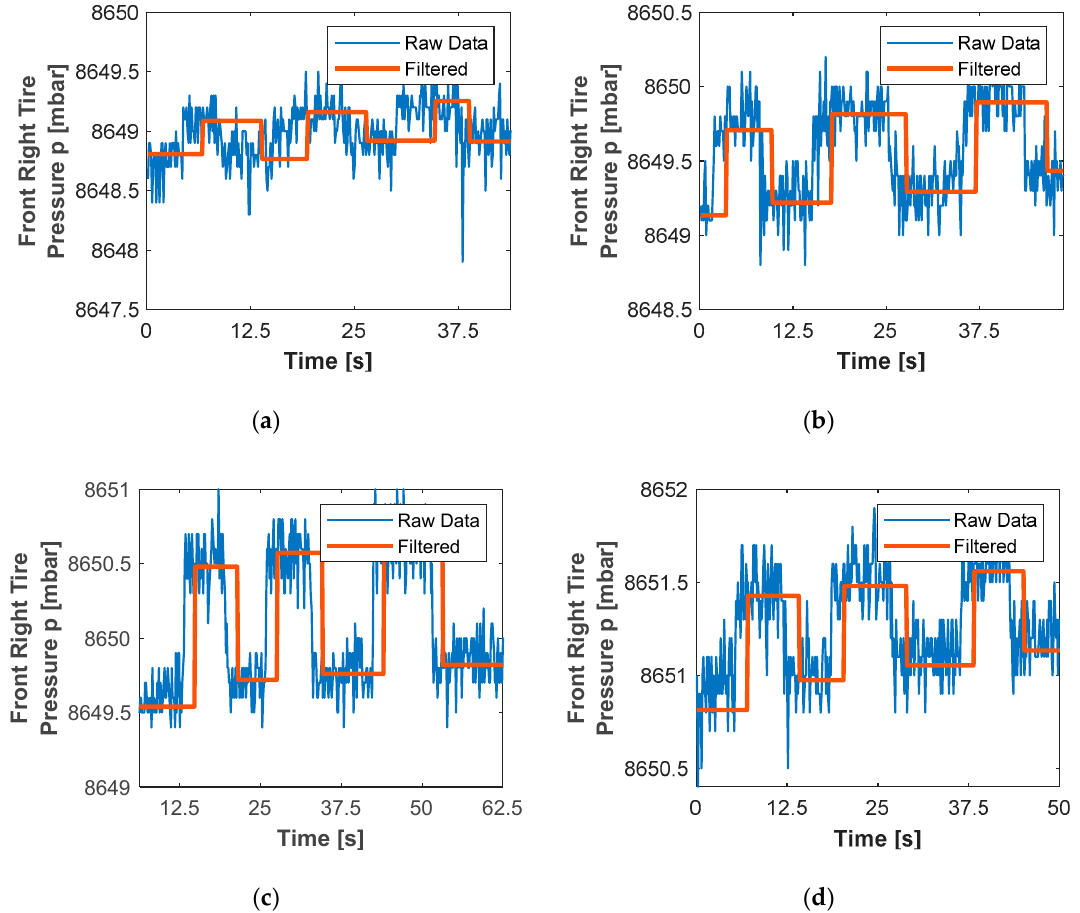
Figure 10. Raw and filtered data for small payloads (bus). ( a ) Ten kilogram front door. ( b ) Twenty kilogram front door. ( c ) Thirty kilogram front door. ( d ) Thirty kilogram middle door.